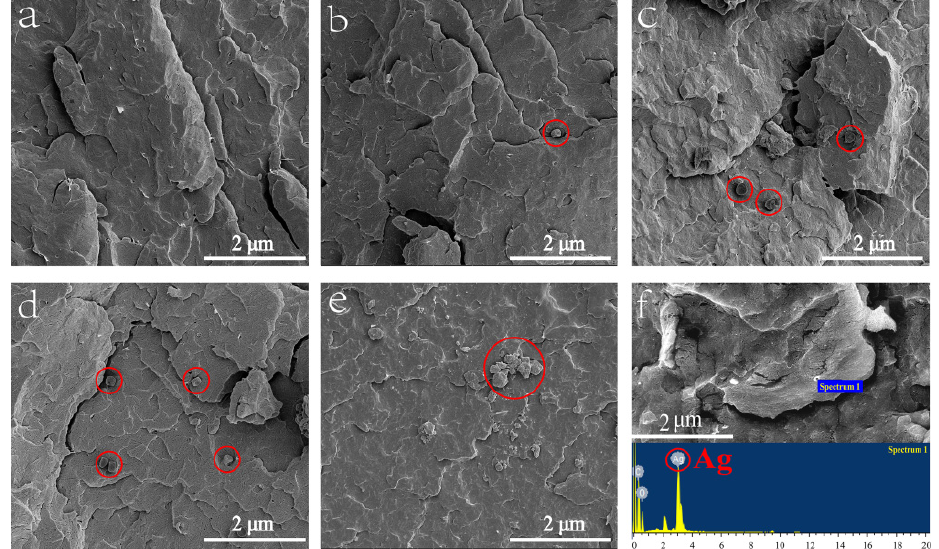
Figure 4. SEM images of polyoxymethylene (POM)/Ag nanocomposites with different Ag nanoparticle contents: ( a ) 0, ( b ) 0.1, ( c ) 0.5, ( d ) 1 and ( e ) 2 wt % (The red circles indicate Ag nanoparticles). ( f ) EDS results obtained at region.